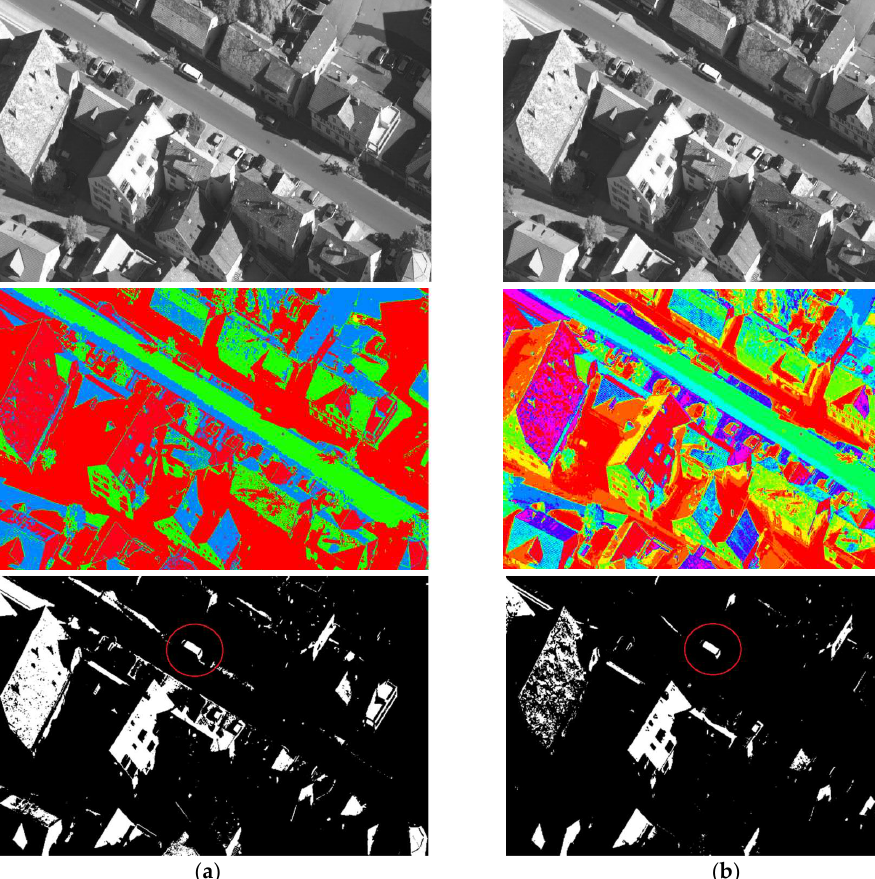
Figure 10. The segmentation results of the Image d. ( a ) 3-level thresholding; ( b ) 9-level thresholding, which separated the target better.